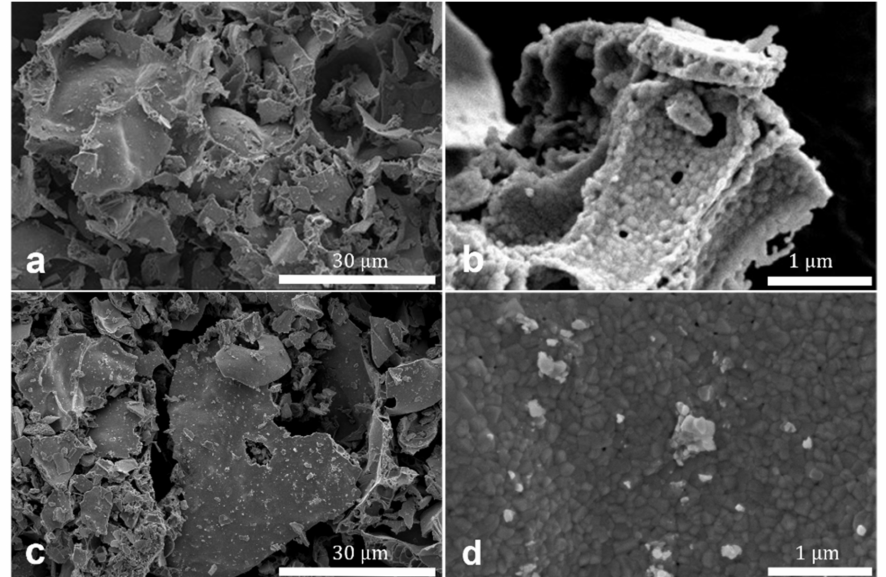
Figure 7. SEM images of Nd09 before ( a , b ) and after a heating ramp ( c , d ) up to 500 ◦ C. All images were recorded with an acceleration voltage of 5 kV. ( a ) Overview, pristine; ( b ) selected area, pristine; ( c ) overview, after reaction; ( d ) selected area, after reaction. After reaction, small CaCO 3 particles are visible (appearing as brighter spots on the darker perovskite